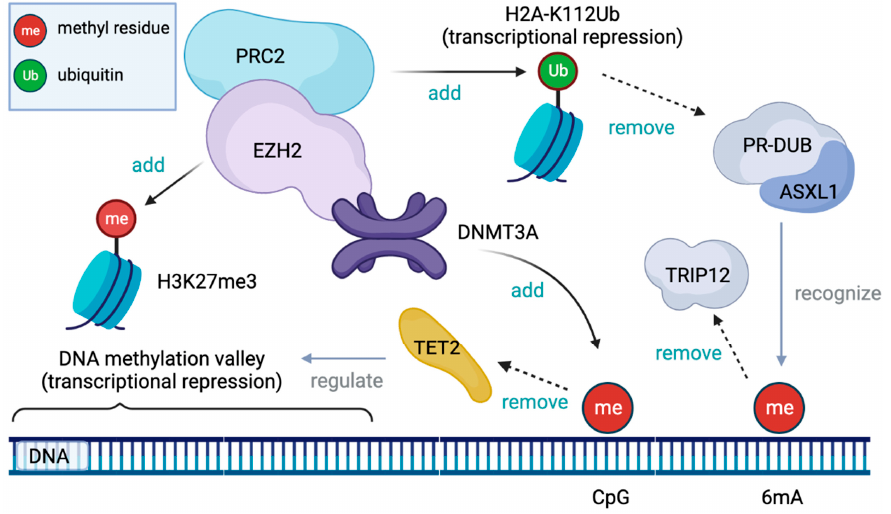
Figure 2. DNA methyltransferase 3A (DNMT3A) proteins methylate cytidine residue linked to the adjacent guanine residue (CpG). Ten-eleven translocation 2 ( TET2 ) protein initiates the demethyla- tion of CpG and contributes to maintaining the DNA methylation valley (DMV). Enhancer of zeste homolog 2 (EZH2) is a catalytic subunit of Polycomb repressive complex 2 (PRC2) and mediates the tri-methylation of the 27th lysine residue of histone H3 (H3K27me3), an epigenetic mark associated with DMVs. PRC2 also mediates the mono-ubiquitination of the 112th lysine residue of histone H2A, a mark of transcriptional repression, which is reversed by the Polycomb repressive deubiqui- tinase (PR-DUB) complex involving additional sex comb-like 1 ( ASXL1 ) as its regulatory subunit. ASXL1 also recognizes methylated adenine (6mA) on DNA and helps its degradation by thyroid hormone receptor interactor 12 (TRIP12). 4.1.2. DNMT3A Mutation DNMT3A mutations are relatively common in patients with cytogenetically normal acute myeloid leukemia (AML) and myelodysplastic syndrome (MDS) [75], accounting for a quarter of AML cases. The majority of the DNMT3A mutations are heterozygous missense mutations located in the 882nd arginine, though a broad range of pathogenic mutation sites have been reported. Because DNMT proteins function as an oligomer, most heterozygous loss-of-function mutations can disrupt part of its methyltransferase activity [76]. A DNMT3A mutation in AML is linked to decreased DNA methylation and a poor prognosis [77] . An analysis of the DNA methylation profiles in patients with cytogenet- ically normal AML revealed that DNMT3A mutations are associated with the hypometh- ylation of genomic regions far from the CpG islands (open see area) and specific promoter regions with a high CpG content such as homeobox (HOX) genes [78]. A mouse model experiment showed that concomitant homozygous Dnmt3a loss and the isocitrate dehy- drogenase 2 ( IDH2 ) gene mutation induced murine leukemia, accompanying epigenomic dysregulation such as the substantially decreased trimethylation (H3K9me3) and acetyla- tion (H3K9ac) of the 9th lysine residue of histone H3, which was reversed by a histone deacetylase (HDAC) inhibitor [79]. A clinical retrospective analysis of patients with MDS who were treated with azacytidine and/or decitabine showed that the DNMT3A mutation